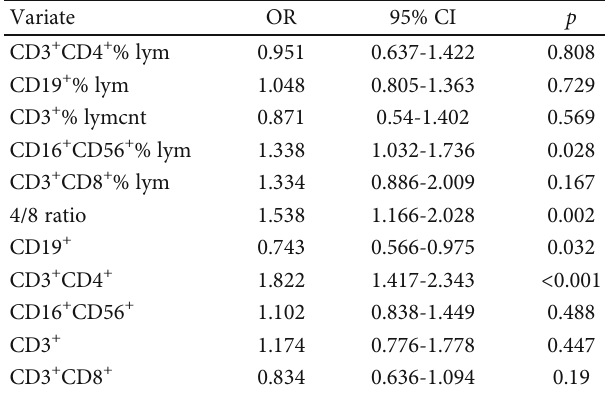
Table 3: Multivariate predictors of COVID-19 versus